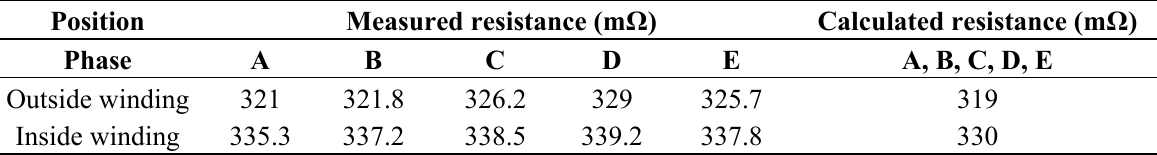
Figure 22. Measuring instrument of resistance and inductance by LCR-281meter. Table 8. The measured and calculated phase resistance of DRPMSM.